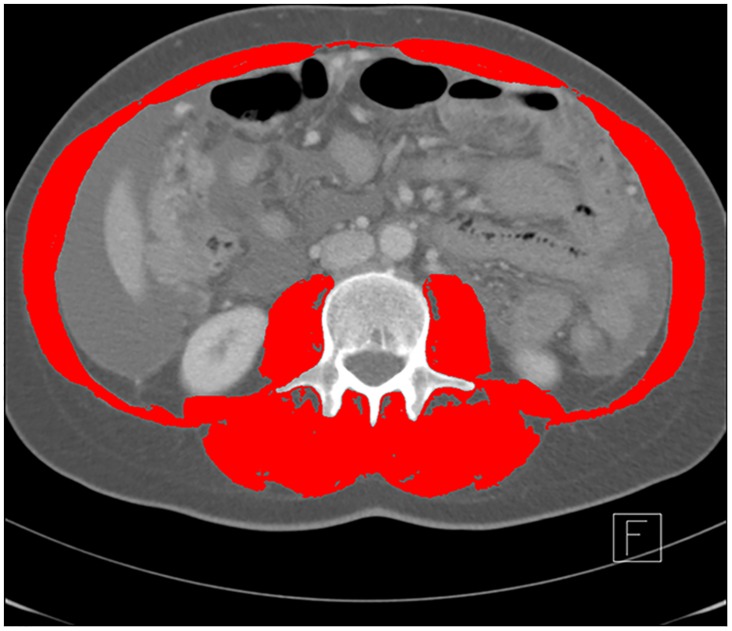
Example of an axial computed tomography (CT) image of the third lumbar vertebra region with the analyzed skeletal muscles highlighted in red.